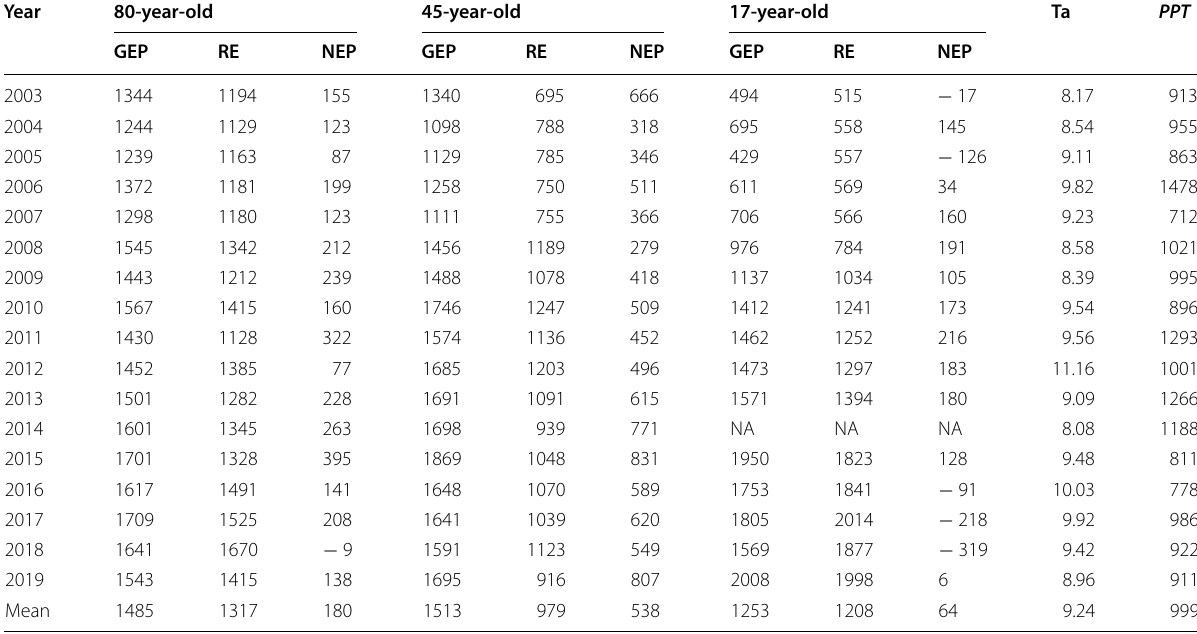
Table 2 Annual values of gross ecosystem productivity (GEP), ecosystem respiration (RE) and net ecosystem productivity (NEP) in